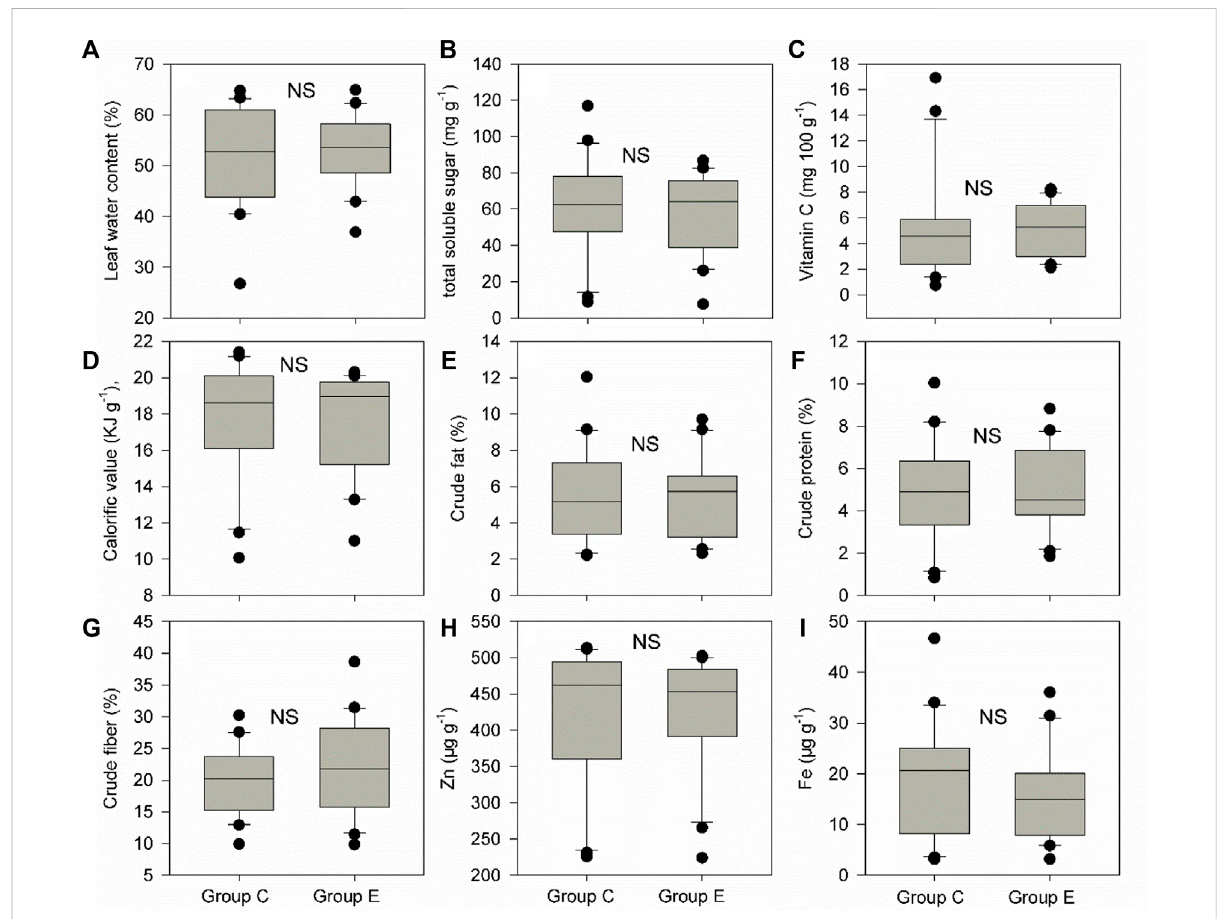
FIGURE 5 Differences in community weighted mean values (CWM) for nine food plant nutrient traits (A-I) between the home range of groups C and E. Theseninetraitsincludeleafwatercontent(%),totalsolublesugar(mgg − 1 ),vitaminC(mg100 g − 1 ),calori fi cvalue(KJg − 1 ),crudefat(%),crudeprotein (%), crude fi ber (%),Zn( μ gg − 1 ),andFe( μ g g − 1 ).Boxplots show themedian(linewithin thebox), 25thand 75th percentiles (theboundariesofthebox), and 90th and 10th percentiles (error bars) of CWM for food plant leaf nutrient traits. NS indicates p > 0.05 and shown are results from Wilcoxon signed rank